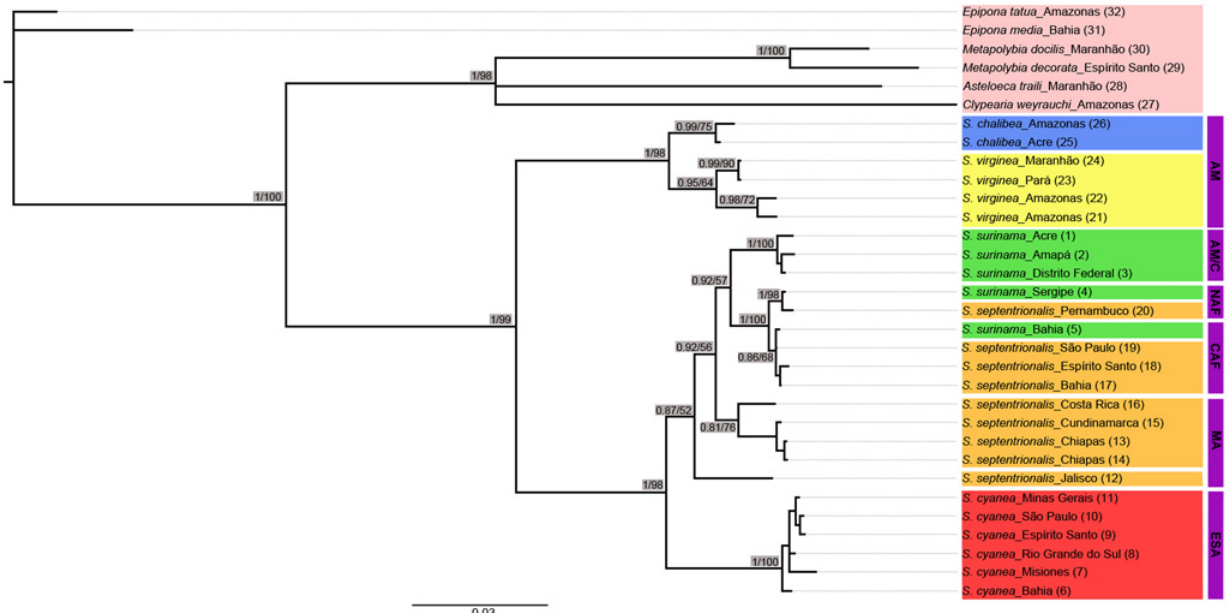
Fig 3. Phylogeny of Synoeca reconstructed by Bayesian analysis. Shown is the consensus tree resulting from analyses based on 1829 bp from 16S, CytB, COI and wingless. Maximum likelihood (ML) analysis resulted in the same topology. Numbers above or below branches indicate Bayesian posterior probabilities (first number) and ML bootstrap values (second number). Numbers in parentheses indicate the collection sites as shown in Fig. 1. Abbreviations for biogeographical units are as follows: AM, Amazonian forest; AM/C, Amazonian forest and Cerrado; NAF, North Atlantic forest; CAF, Central Atlantic forest; MA, Middle America; ESA, Eastern portion of South